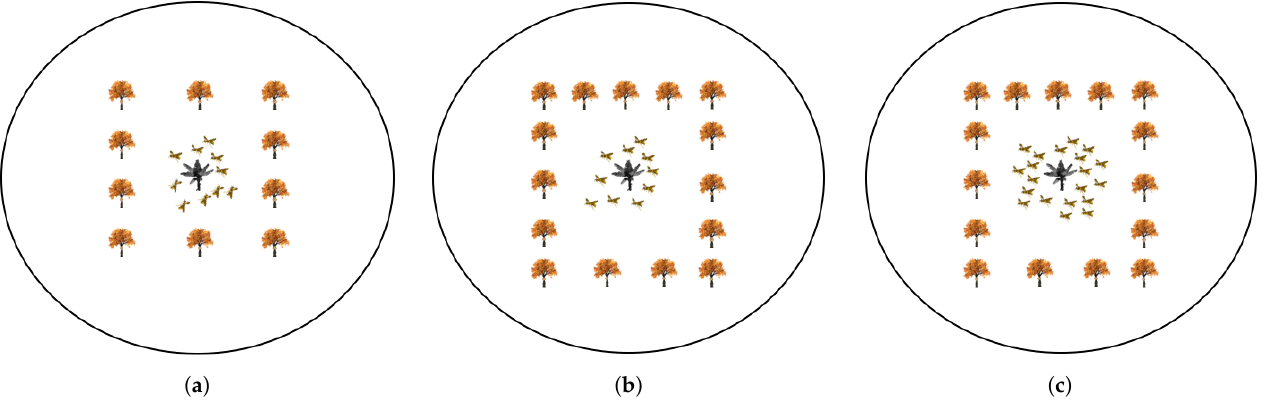
Figure 5. Search space environment of experiment. ( a ) Experiment 1. ( b ) Experiment 2. ( c ) Experiment